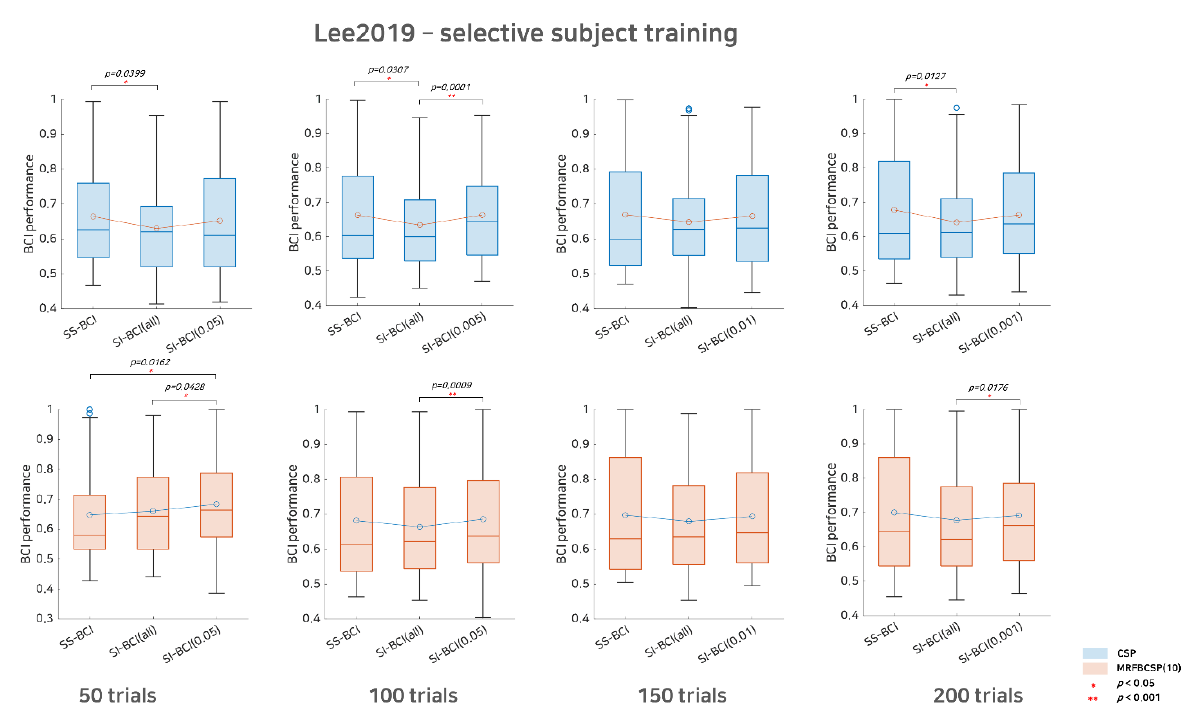
Figure 4. Comparative analysis of SS BCI and SI BCI performance for the Lee2019 dataset. This represents SS BCI performance, SI BCI performance using all subjects available (SI BCI-All), and SI BCI performance using selective subject training (SI BCI- α ) for the Lee2019 dataset. Blue colored boxplots indicate the CSP method and red colored boxplots denote the MRFBCSP method. Blue colored circles in boxplots denote outliers.